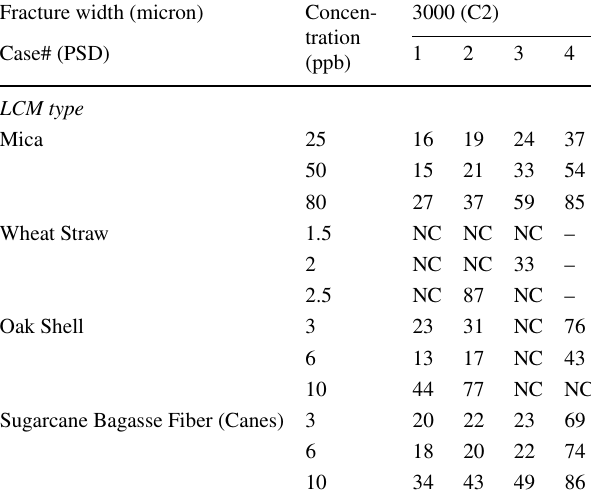
Table 6 LPA fluid loss results in (ml) for individual LCM Fracture width (micron) Concen-